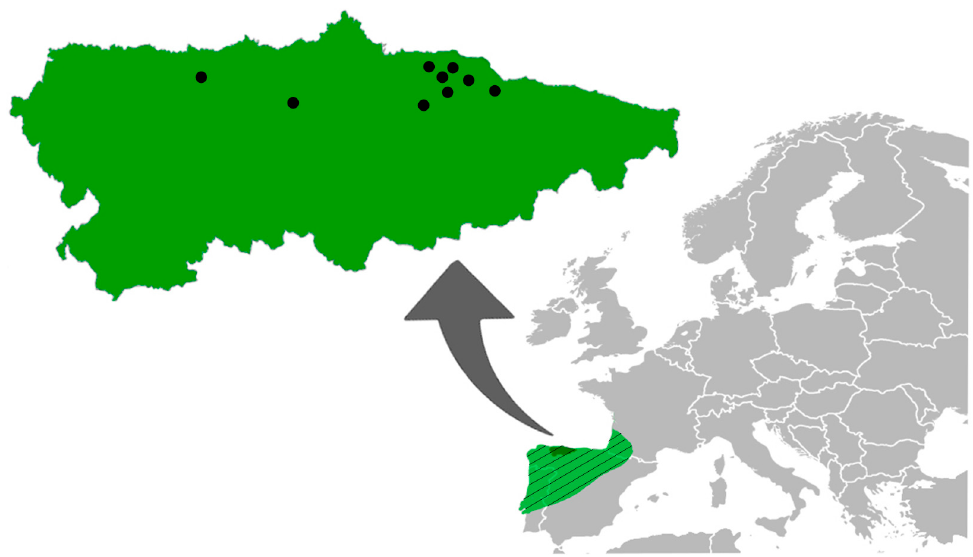
Figure 1. Distribution of Microtus lusitanicus in the Iberian Peninsula ( striped green ) and map of Asturias ( dark green ) showing the trapping sites of the individuals analysed ( black points ).